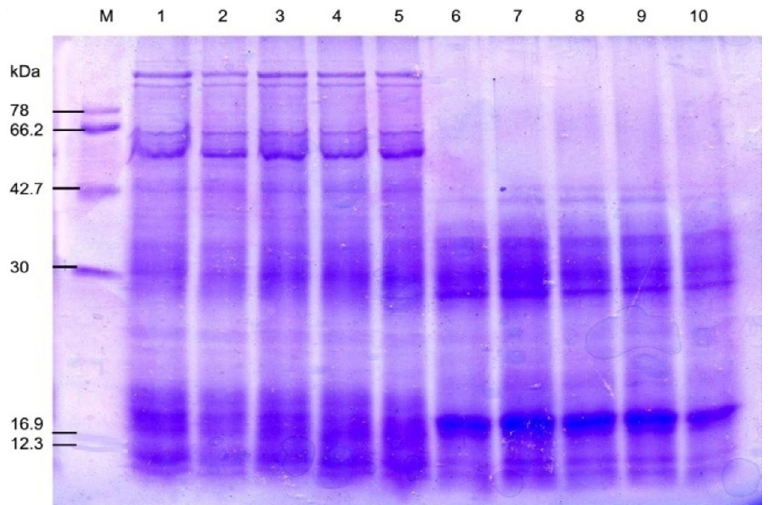
Fig. 5. SDS-PAGE of the protein profiling of three sub-aerial cyanobacteria isolates: Scytonema coactile Lane 2-5 and S.geitleri Lane 7-10 after exposure to different duration of temperature for 8 hours (35°C, 45°C, 55°C) and 3 hours (65°C), then incubated for 15 days under continuous illumination (2000 lux) at 25±2°C. An equal amount of proteins were loaded into each well. Control (25°C), Lane 1, 6; M. Molecular mass of standard proteins in